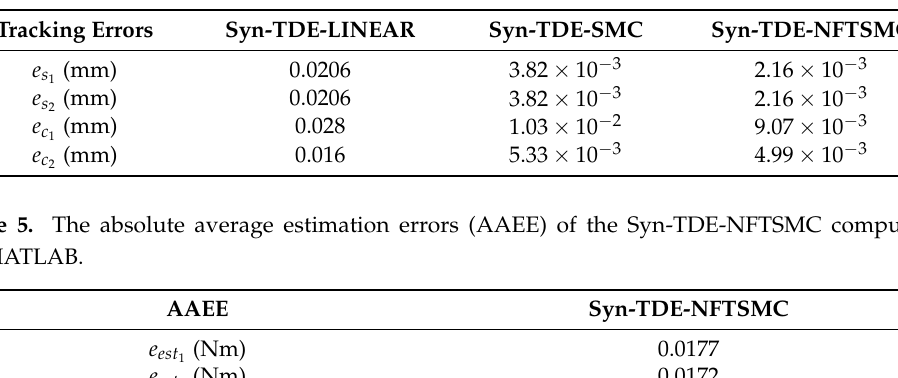
the control schemes, computed by MATLAB.